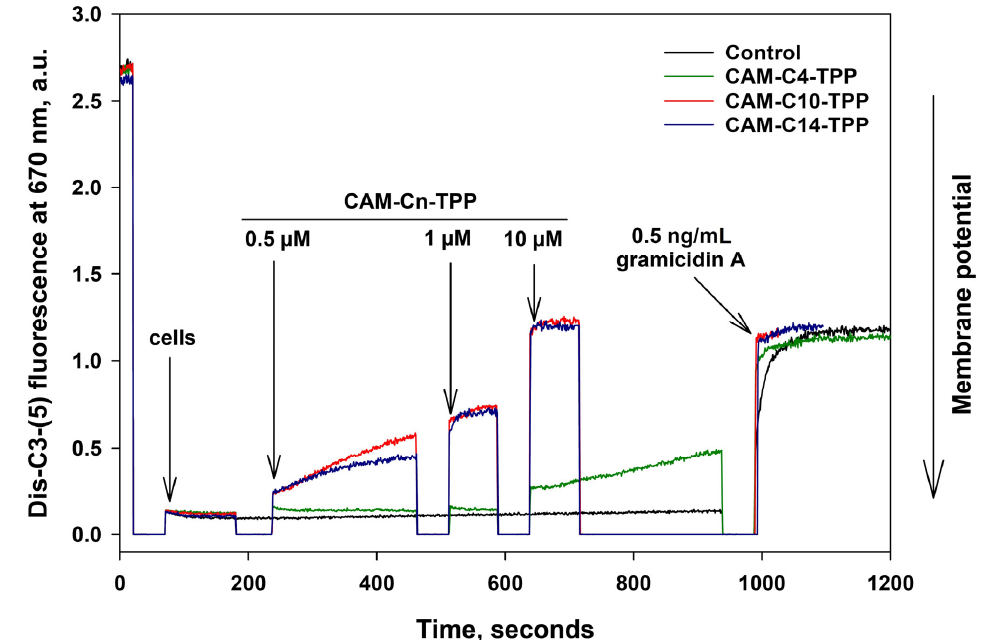
Figure 4. Dose-dependent effect of CAM-Cn-TPP on the kinetics of the membrane potential of B. subtilis cells, as assessed by DiS-C3-(5) (10 µ M) fluorescence in a PBS buffer. To reach the desired concentrations, appropriate amounts of CAM-Cn-TPP were added at different moments, which are marked by the arrows. The Gramicidin A concentration was 0.5